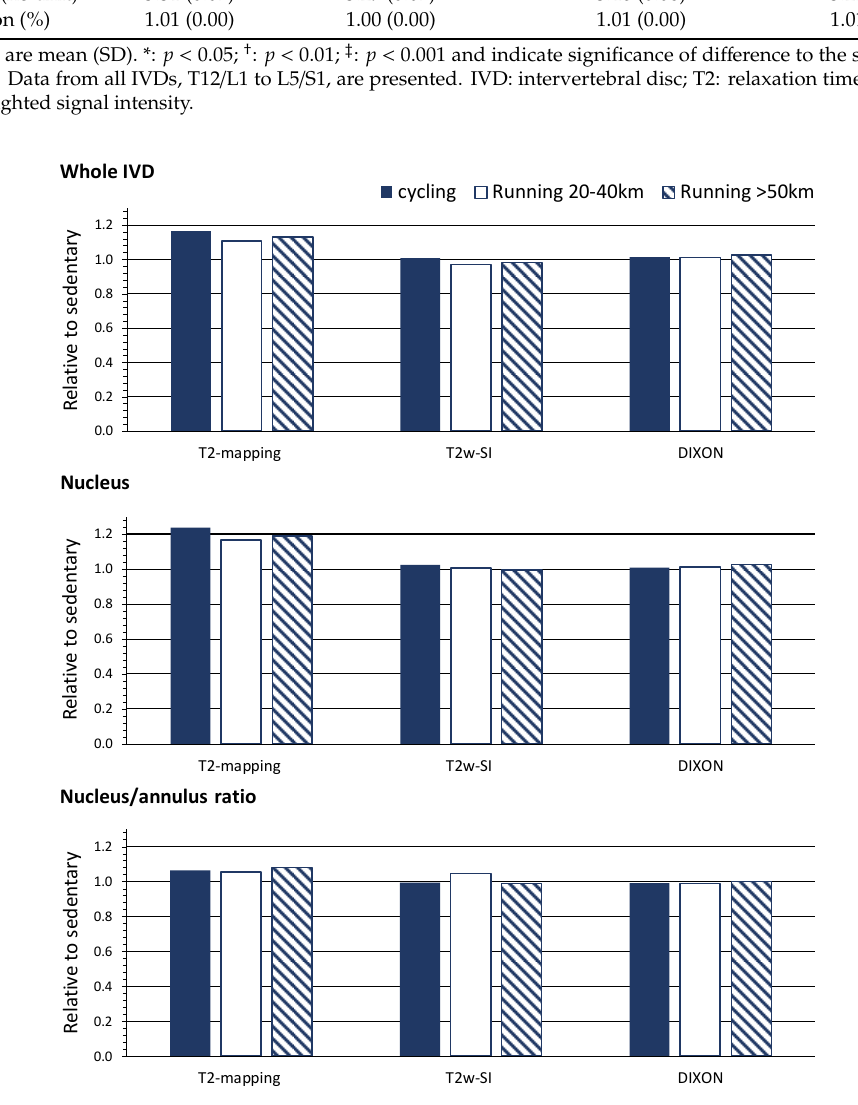
Figure 2. Differences of each MRI technique in quantifying the intervertebral disc. Data are relative differences in physical activity histories compared to the sedentary group. See Table 1 for statistical comparisons.